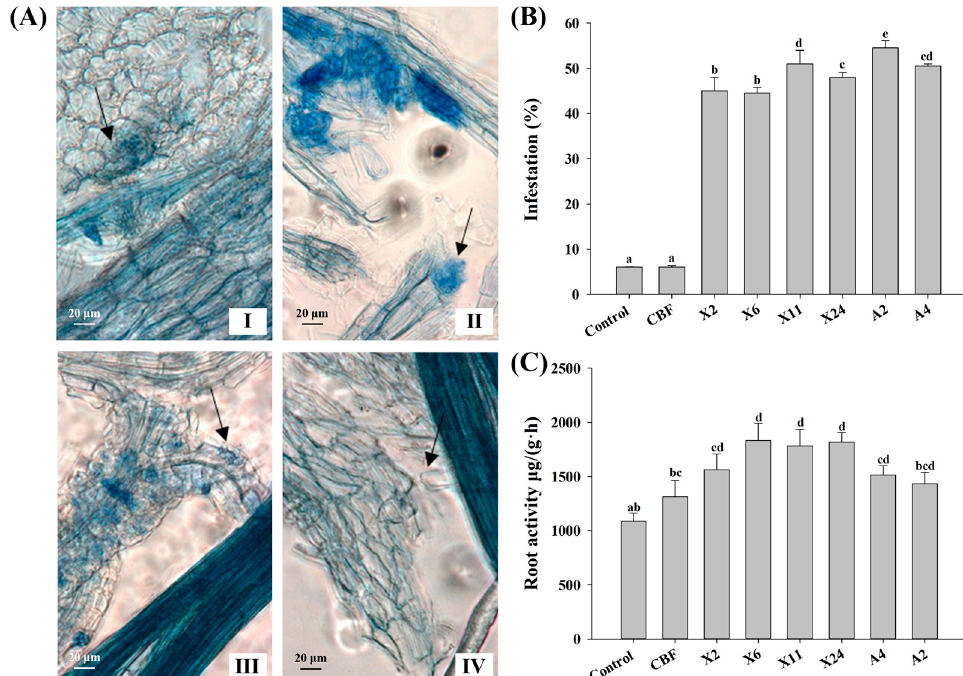
Figure 3. Infestation status and root activities of the seedlings after inoculation with endomycorrhizal fungi. ( A ) Picto- graph of fungal colonization morphology in blueberry roots under 100× magnification, depicting hyphal structure: (I) intracellular mycelial coils; (II) intracellular mass; (III) intercellular spread via gaps between cells; and (IV) longitudinally or laterally intercellular and intracellular extension. The black arrow points to the mycelial structure. ( B ) Infection rate of blueberry seedlings after inoculation with different fungi. ( C ) Effect of fungal inoculation on blueberry root activity. Con- trol plants were treated with conventional organic fertilizer with nutrient solution, CBF was treated with commercial bacterial fertilizer, and the remaining treatments were treated with conventional organic fertilizer with nutrient solution, then inoculated with beneficial endomycorrhizal fungi isolates. Columns marked with different lowercase letters indicate significant differences ( p < 0.05) between genotypes. Error bars represent the standard error of means ( n =